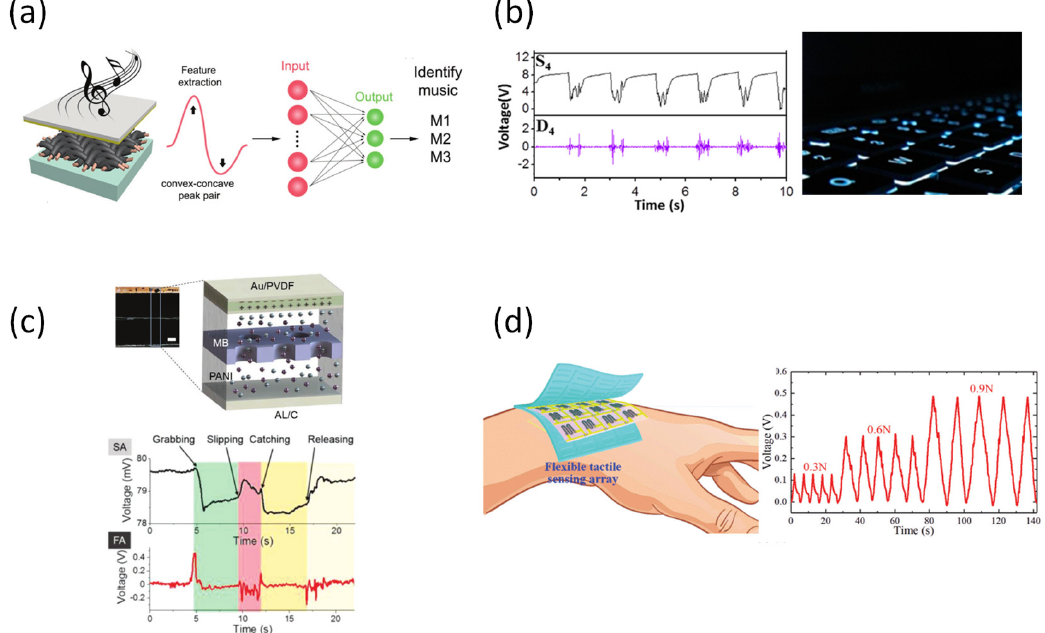
Figure 10. ( a ) A hybrid array on copper mesh sound sensor for artificial intelligence [154]. ( b ) Keystroke tactile for human-machine interface [155]. ( c ) Self-power sensor mimicking slow/fast-adapting cutaneous mechanoreceptors [156] ( d ) Highly flexible tactile sensor with an interlocked truncated sawtooth structure based stretchable rubber composites [157].